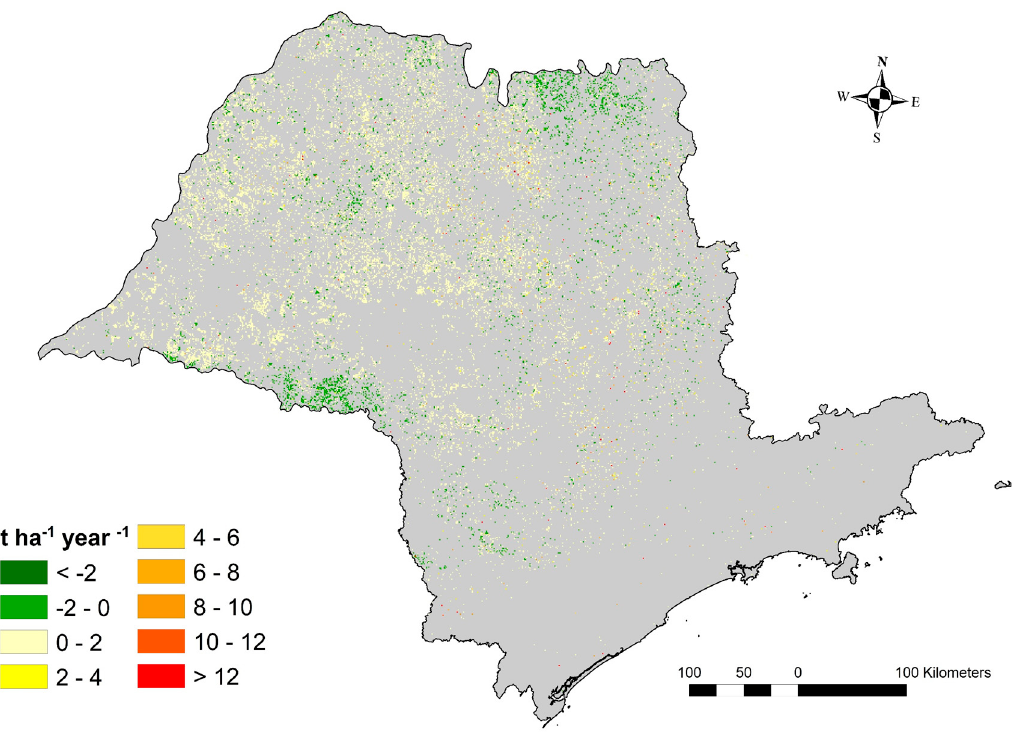
Figure 4. Di ff erence in soil loss between sugarcane and land use / cover prior to conversion in the time Figure 4. Difference in soil loss between sugarcane and land use/cover prior to conversion in the time period of 2005 to period of 2005 to 2015.